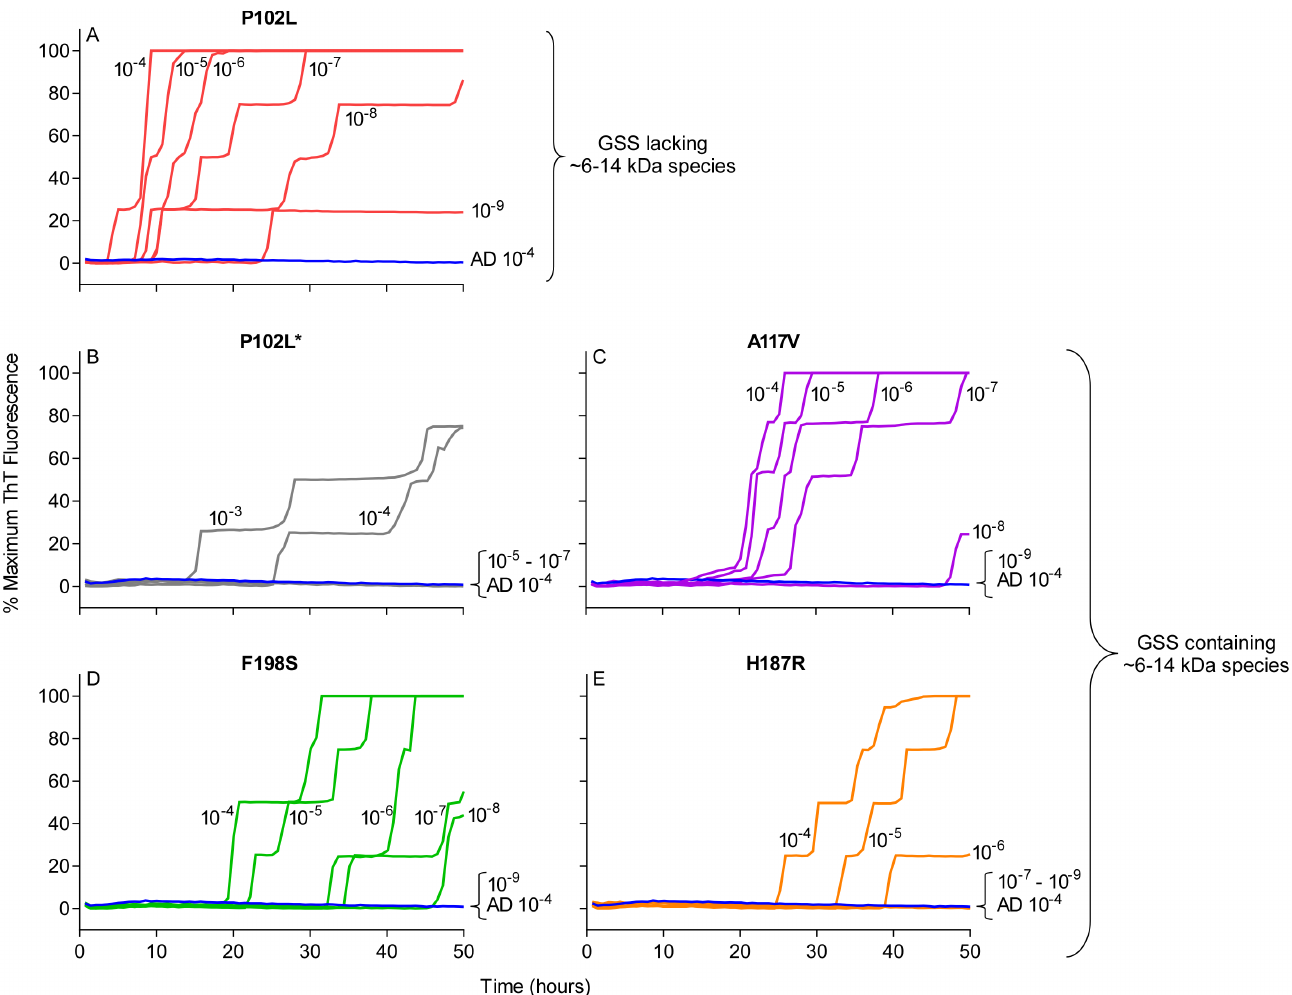
Fig 3. RT-QuIC sensitivity for detection of human GSS P102L, P102L * , A117V, F198S, and H187R seeding activity using BV rPrP Sen . The designated dilutions of frontal cortex brain tissue from the designated GSS P102L (A), P102L * (B), A117V (C), F198S (D), and H187R (E) patients were used to seed RT-QuIC reactions with 0.001% SDS and 300mM NaCl. Negative control reactions were seeded with Alzheimer ’ s disease (AD) brain tissue (A-E, blue lines). Representative data from one of three independent experiments is shown as the averages of fluorescence values from four replicate wells.